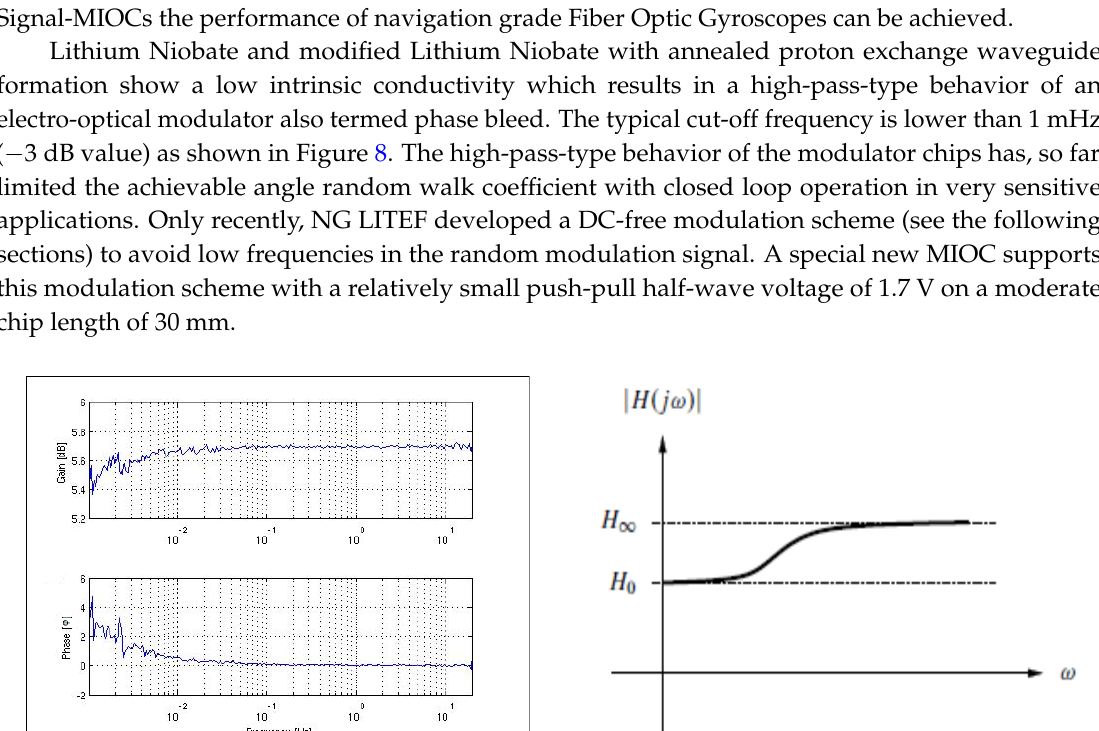
Figure 7. ( a ) Block diagram showing a single-axis closed-loop FOG including signal processing datapath; ( b ) Block diagram showing FOG modulation frequency tracking.